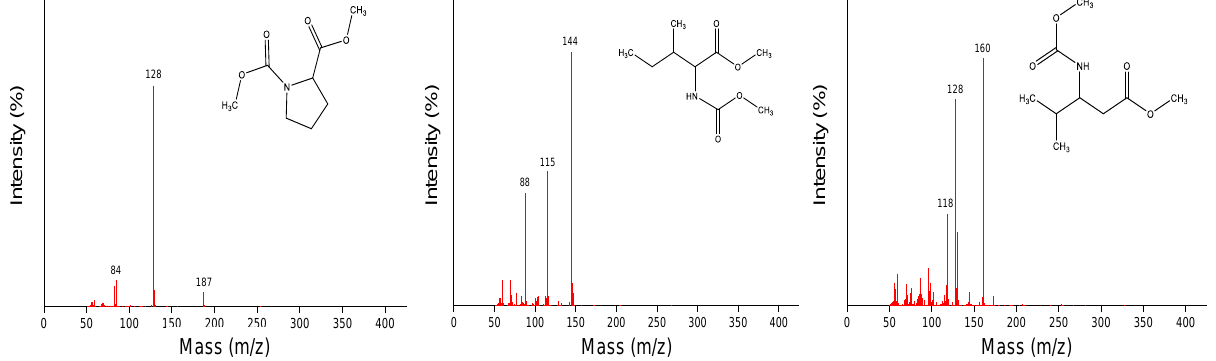
Figure 10. Mass fragmentograms of three compounds: proline, isoleucine and beta-leucine extracted from coelution peak 3 at 2.14 min using specific mass fragments ( m/z 128, 144 and 160, respectively).